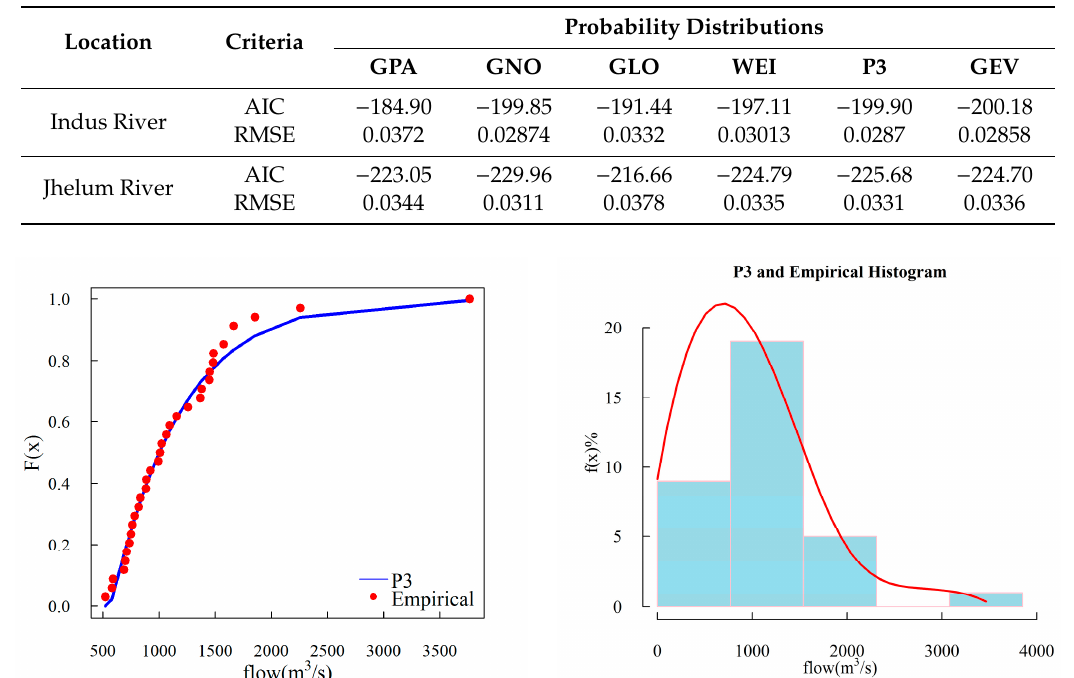
Figure 3. Cumulative distribution and empirical histogram of historical data fitted by Pearson type III (P3) distributions for Jhelum river.